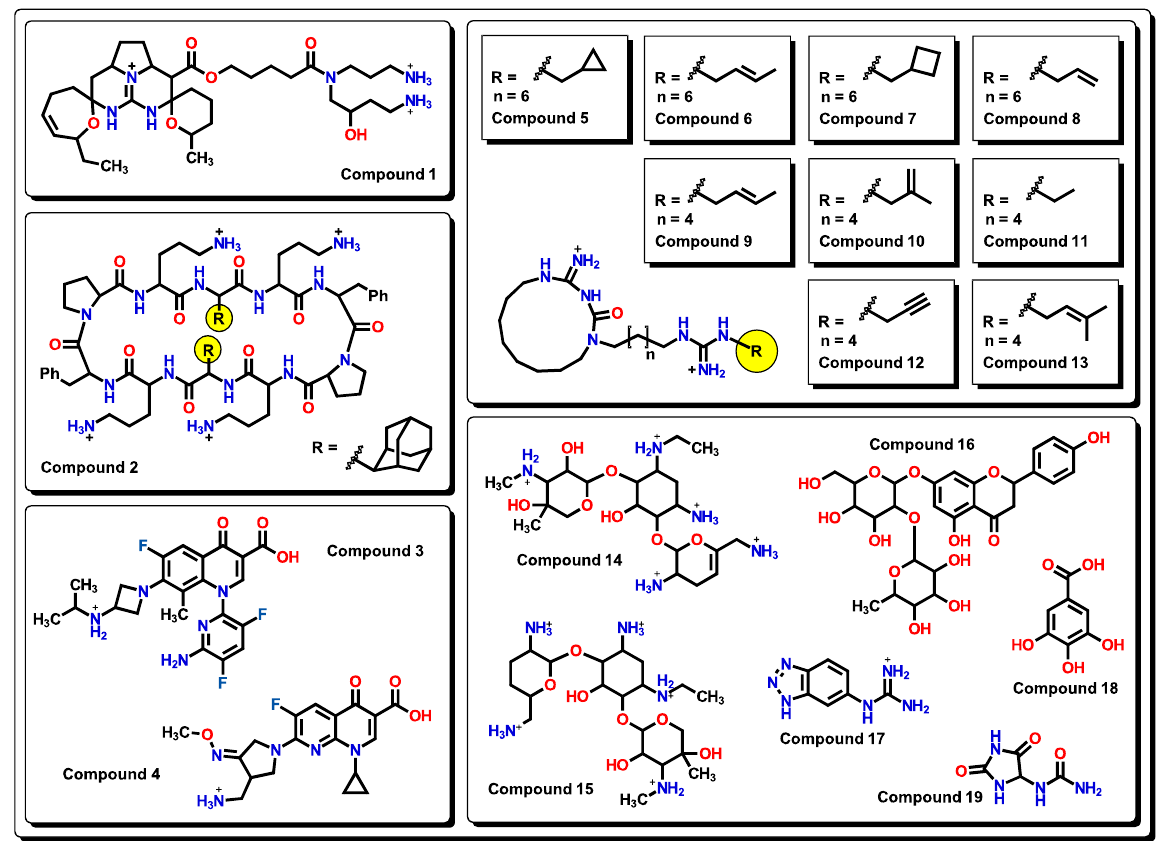
Figure 3. Chemical outliers obtained from the analysis of the Williams plots. dataset were employed as an external validation set to obtain their predicted p MIC values. Three sets of compounds were used as follows: (a) the first set of molecules reported by Matsingos et al. [52]; (b) compounds reported by Singh [53], Wang [54], and Zhou [55] as the second set, and finally, (c) chemical structures described by Lyons and collaborators [56]. For the three sets of data, there is a good correlation between experimental and predicted p MIC values with R 2 values of 75.54, 71.64, and 71.56,